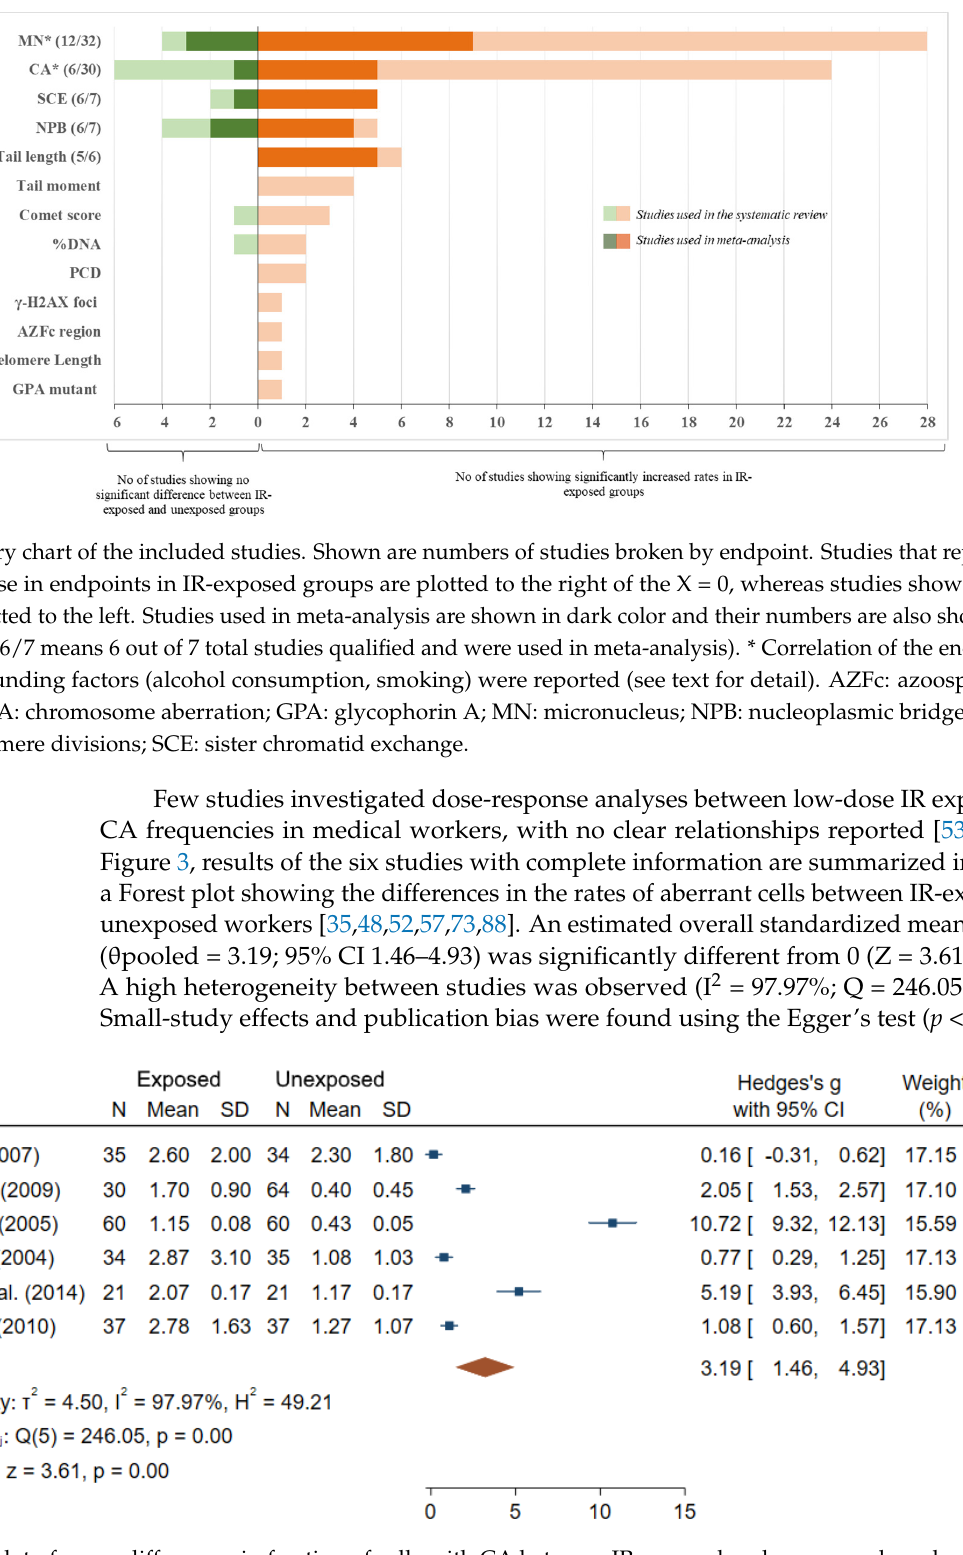
Figure 3. Forest plot of mean differences in fraction of cells with CA between IR exposed and unexposed workers. The blue squares represent the differences in standardized means between IR-exposed and non-exposed workers for each study individually (with their associated blue bar corresponding to the confidence interval of each mean), while the brown diamond below corresponds to the estimated overall standardized mean difference (placed in the center of the diamond, with the bounds of the confidence interval being at the extreme points of the diamond).